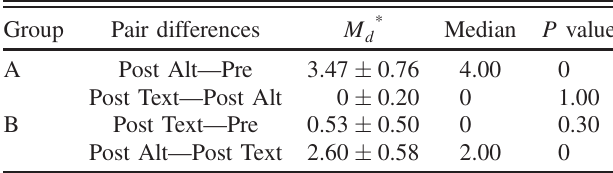
TABLE III. The motion of air molecules in sound standing waves: Gain scores for group A and group B ( n ¼ 15 for each